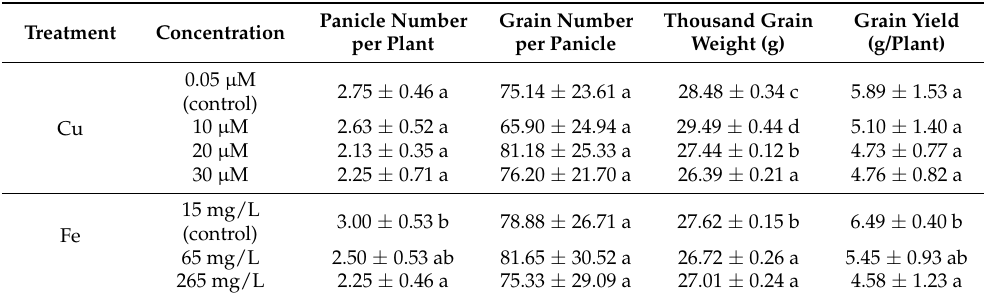
Table 1. Effect of Cu and Fe treatments on the yield components of rice. Grain yield is the product of panicle number per plant, grain number per panicle and the thousand grain weight/1000. For each yield component, the data are means ± SD ( n = 8), with significance determined by one-way ANOVA followed by Tukey’s post hoc test ( p < 0.05, as denoted by different